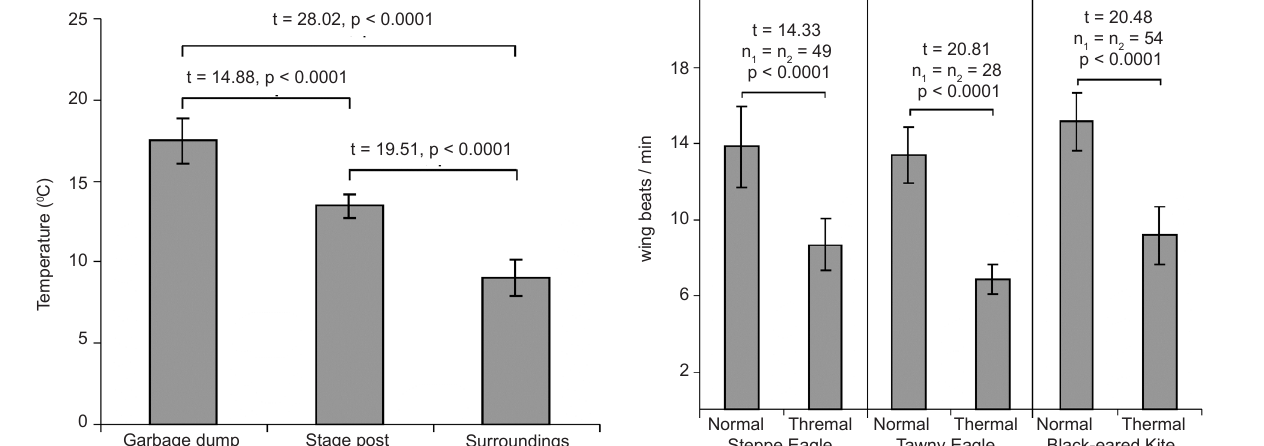
Figure 2. Mean and standard deviation of wing beat rates of three species of migratory raptors before arrival (normal) and over the garbage dump site (thermal). The wing beat rate over the thermal is significantly